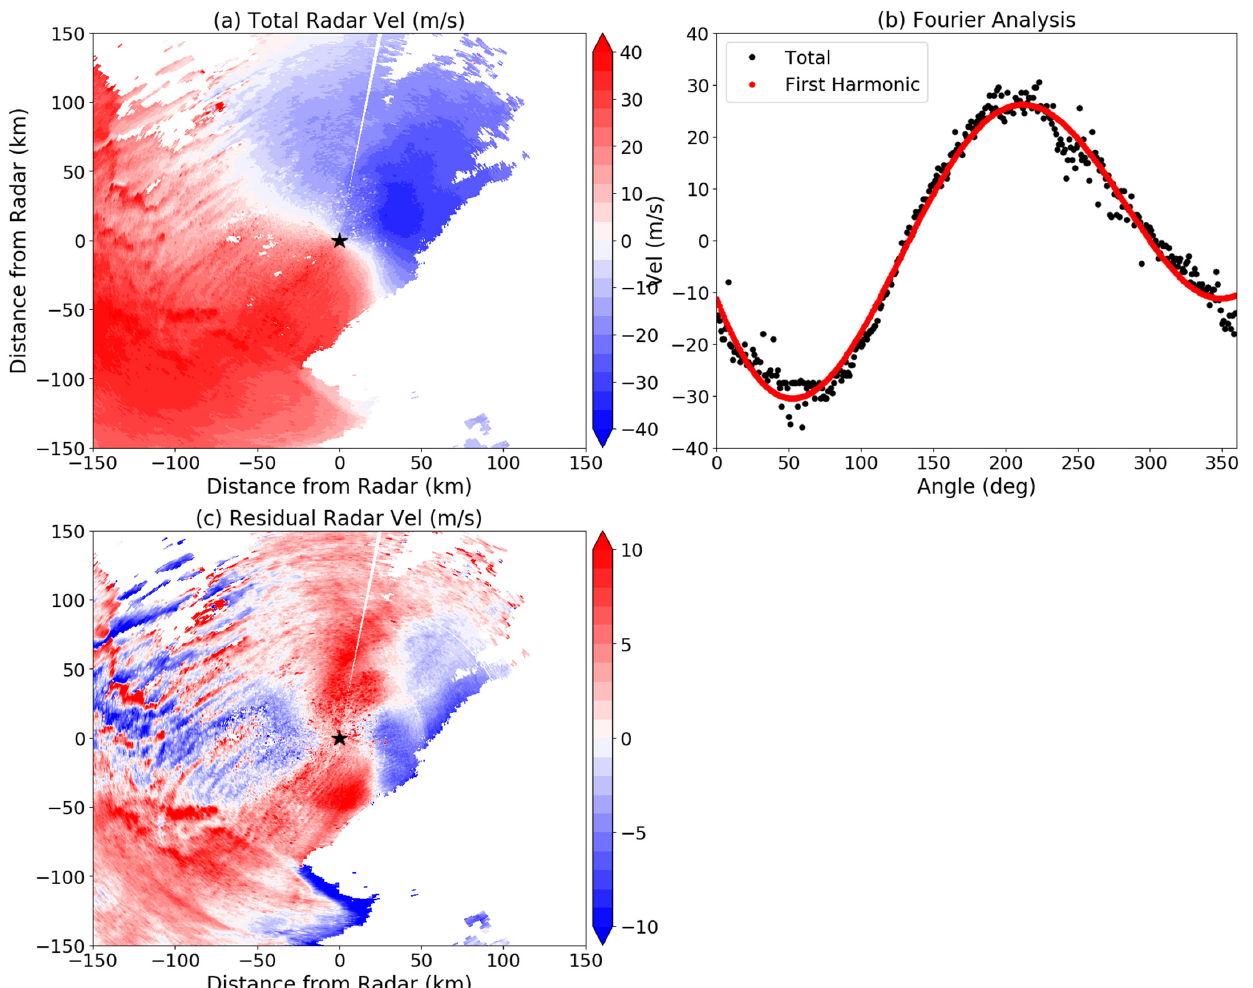
Figure 3. A demonstration of Fourier analysis of the radar radial velocity. ( a ) The total radar radial velocity. ( b ) Comparison between the total radar radial velocity and the first harmonic obtained using the Fourier analysis at a radius of 25 km. ( c ) The radar residual velocity obtained by subtracting the first harmonic from the total radar residual velocity.